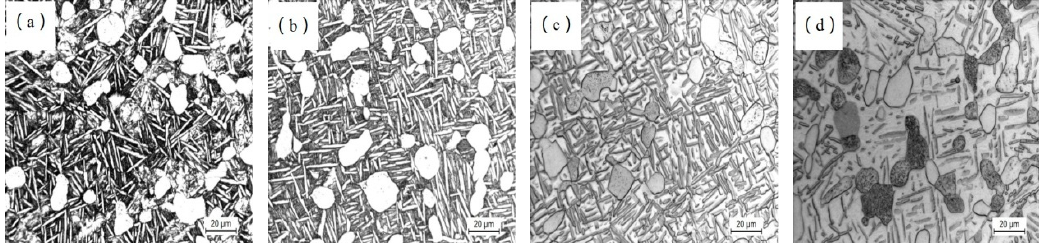
Figure 5. Optical microscopy images of the specimens after heated up from initially microstructure III: ( a ) 700 °C, Water quenched (WQ); ( b ) 800 °C, WQ; ( c ) 940 °C, WQ; ( d ) 970 °C, WQ.